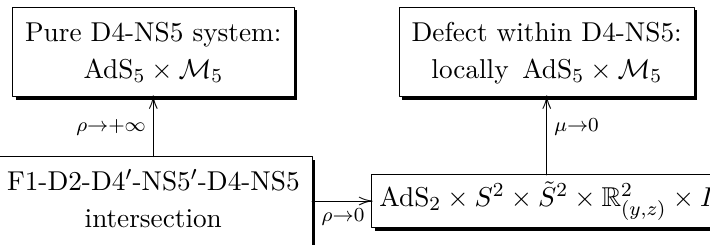
Figure 1 . The ρ → + ∞ and ρ → 0 limits of the F1-D2-D4 0 -NS5 0 -D4-NS5 brane intersection of table 1, with its defect structure. The ρ → + ∞ limit zooms out the F1-D2-D4 0 -NS5 0 branes, leaving behind an AdS solution associated to the D4-NS5 branes. The ρ → 0 limit produces an 5 × M 5 AdS near horizon geometry which, in turn, approaches asymptotically the AdS 2 the µ → 0 limit, allowing one to interpret the F1-D2-D4 0 -NS5 0 branes as describing a defect within the 4d SCFT associated to the D4-NS5